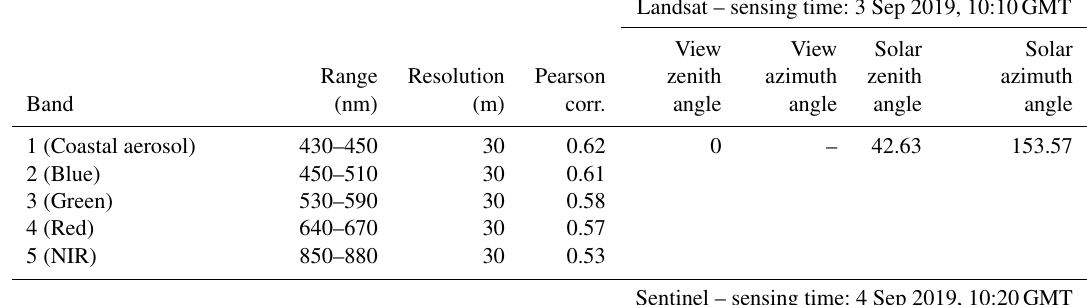
Table 3. Band names and respective wavelength range and resolution for Landsat and Sentinel as used in this study. Pearson correlation given for mean band values of ground measurements and associated satellite data. For Landsat, the solar zenith and azimuth angles given in the surface reflectance image are listed. The view zenith angle is hardcoded to 0 in the Land Surface Reflectance Code (LaSRC_1.3.0) for the Landsat surface reflectance product, as per the LaSRC documentation (USGS, 2020). For Sentinel, the incidence angles refer to the mean viewing zenith and azimuth angles for each band. The solar angles are the averages for all